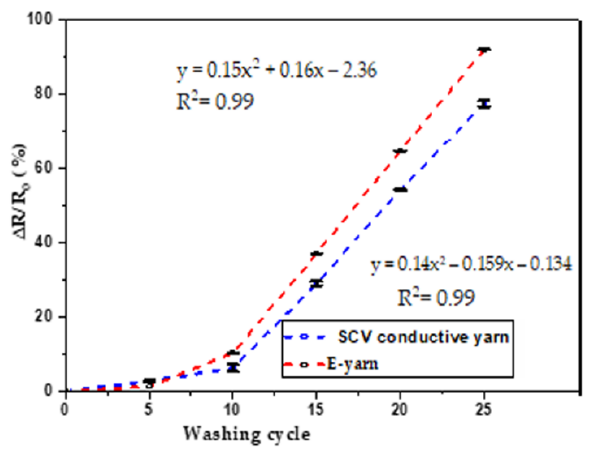
Figure 13. Effects of washing on resistance of conductive yarn and E-yarn.